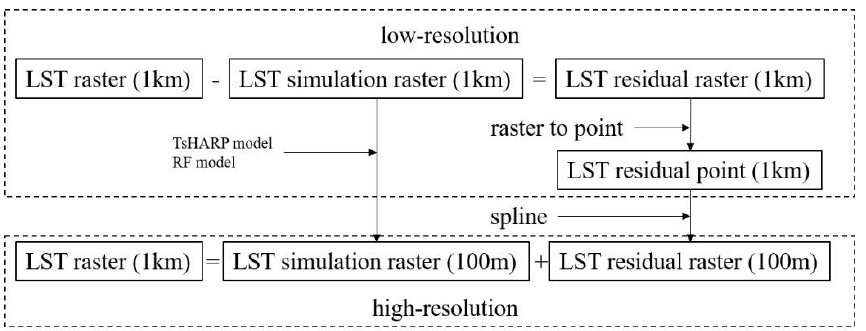
Figure 4. Fit residual flow chart.